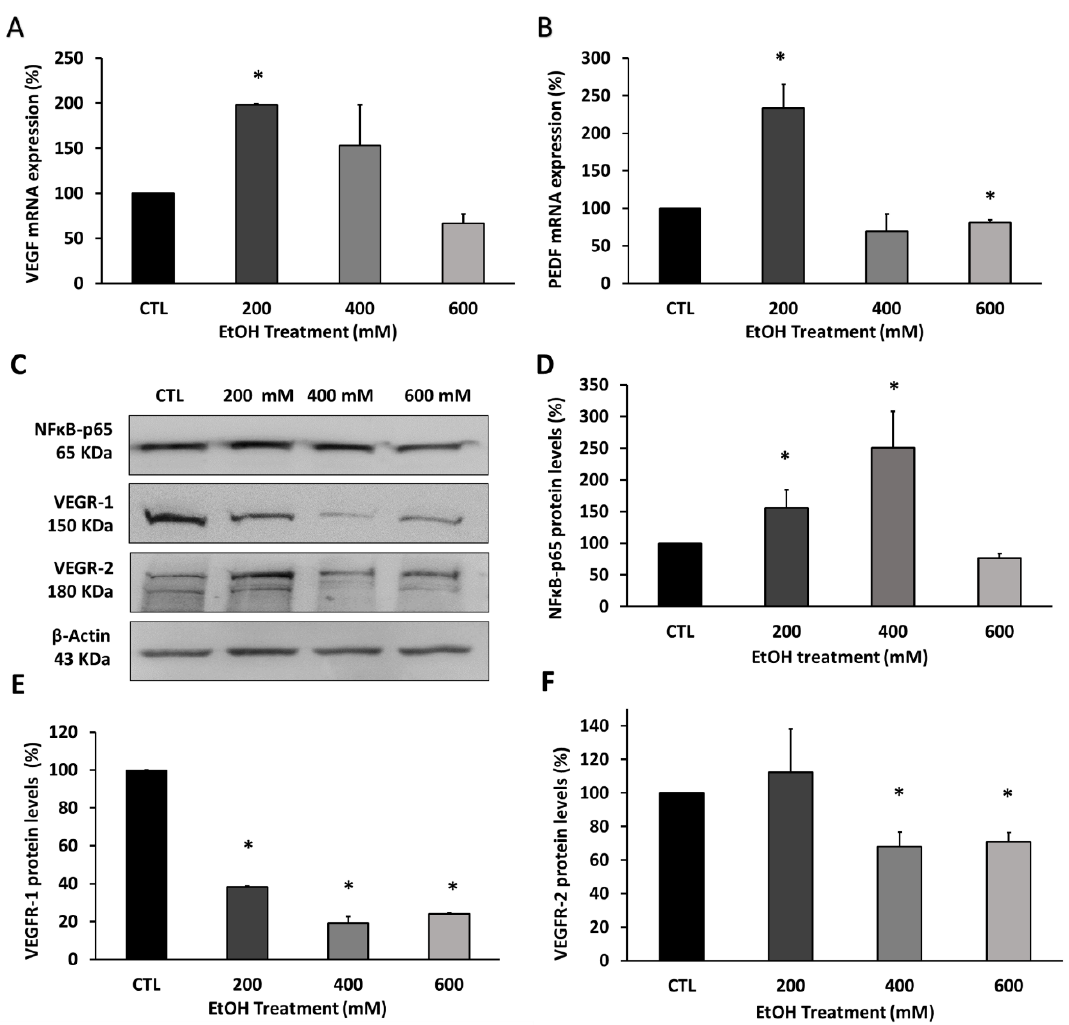
Figure 4. Growth factors and angiogenesis biomarkers in ARPE-19 cells after EtOH treatment. ( A ) VEGF and ( B ) PEDF mRNA expression quantification by qPCR. ( C ) Representative pictures of protein levels quantification by western blot (WB) of ( D ) p65-NF к B, ( E ) VEGFR-1 and ( F ) VEGFR-2. Gene expression was normalized by GAPDH gene expression. Protein levels were normalized by β -actin. Values are expressed as mean ± SEM (N = 3). Statistically significant di ff erences were set at * p < 0.05 vs. CTL group.